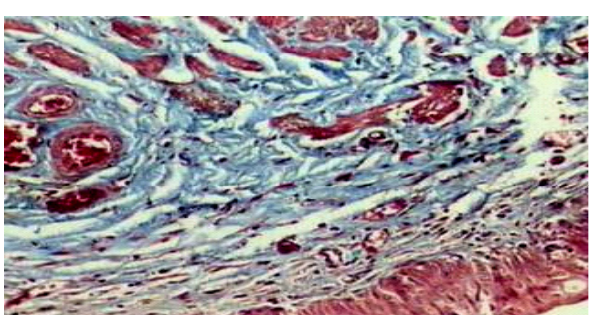
vascular capilar e angiogênese moderada com fibrose na área de sutura no 3º dia pós- operatório (subgrupo Jatropha , coloração H.E., aumento 100x). Nota: Neoformação